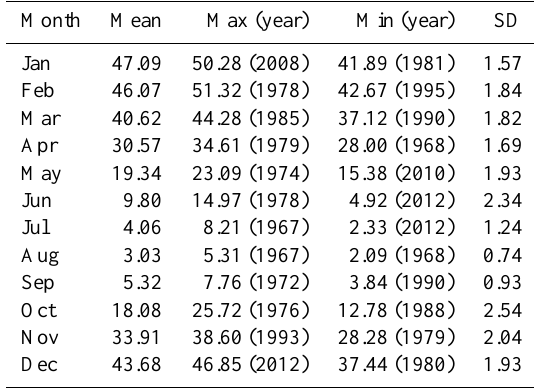
Table 2. NH SCE CDR monthly statistics (and year of max/min) in millions of square kilometres. Calculated using a data